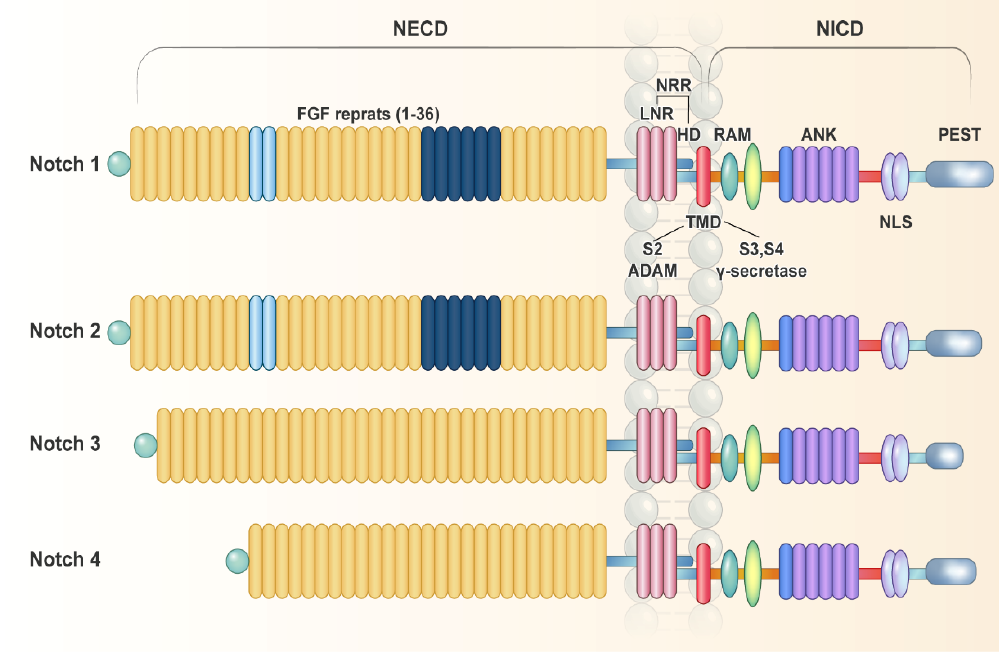
Figure 2. Schematic illustration of Notch receptors.